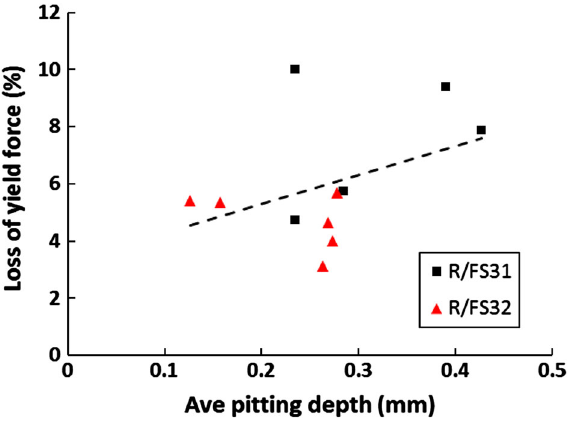
Fig. 11 Influence of average pitting depths on loss of yield force of steel in